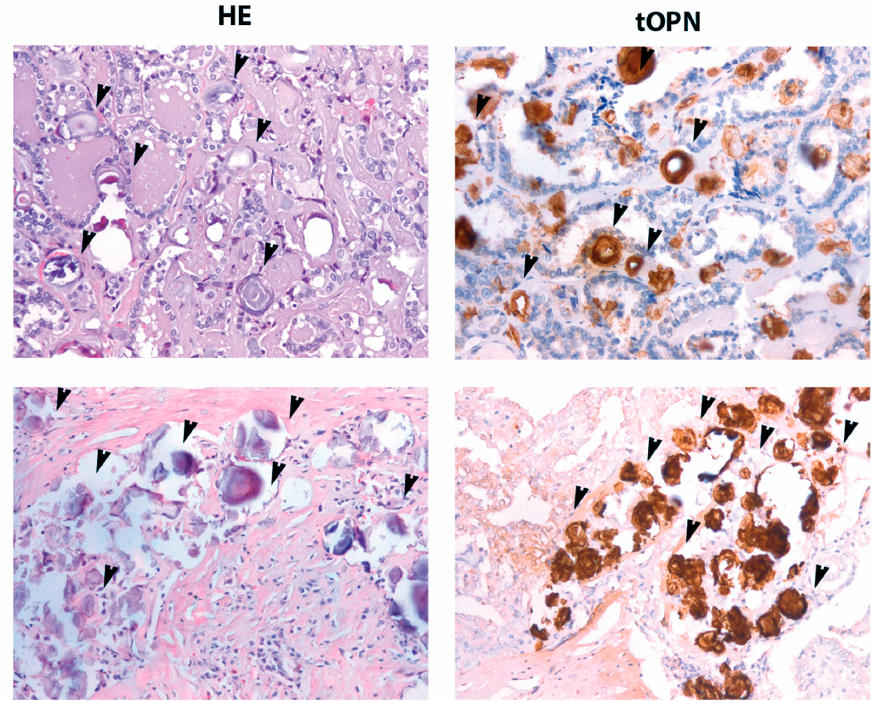
Figure 1. Total Osteopontin (OPN) staining at psammoma bodies (PB) in classical variants of papillary thyroid carcinoma cPTC cases. Two different representative cPTC cases ( upper and lower panel ) showing psammoma bodies with black arrow heads. Left panel : PB stained by HE, 40×. Right panel : PB stained for total OPN (tOPN) antibody, 40×.